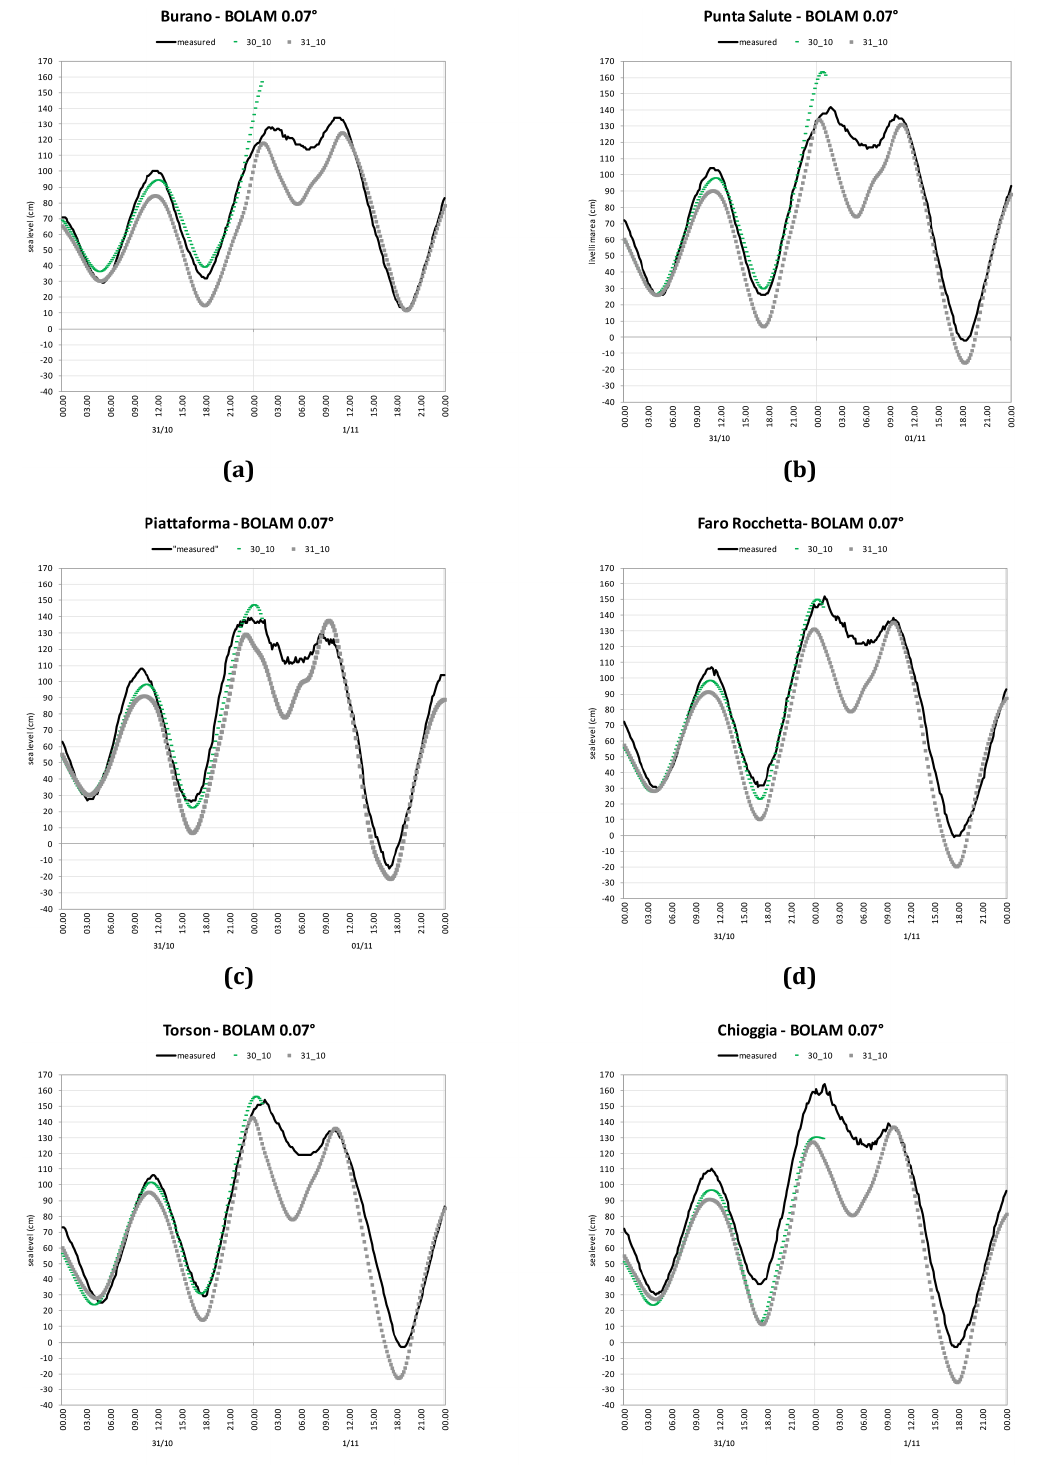
Figure 17. As in Fig. 15, but with the meteorological forecast forcing provided by the 0.07 ◦ BOLAM from 30 to 31 October: (a) Burano; (b) Punta della Salute; (c) Piattaforma; (d) Faro Rocchetta; (e) Torson; (f)